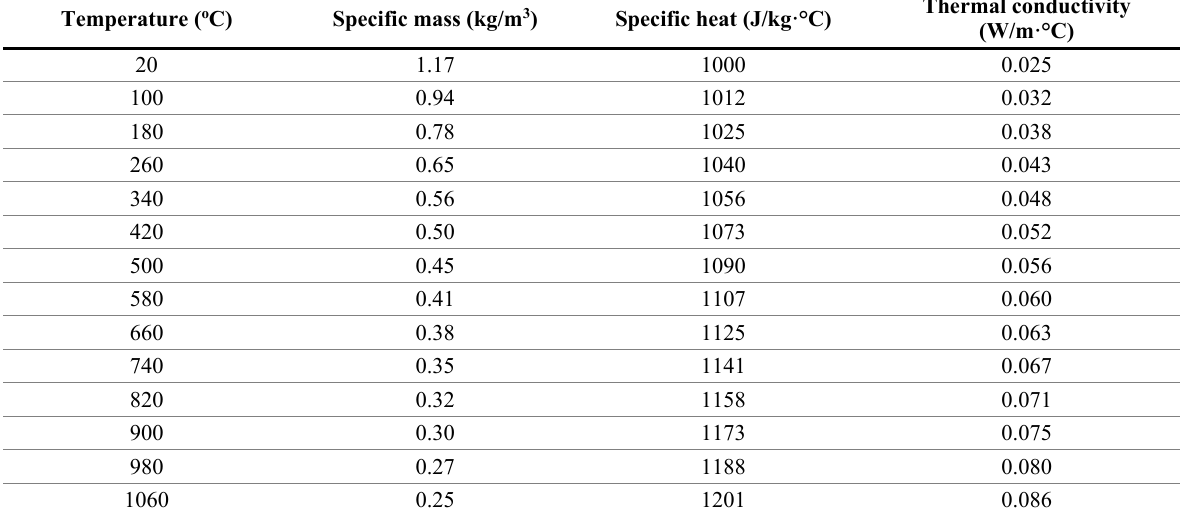
Table 2. Air properties inside the cavity of the box-type fire protection coating, Ribeiro